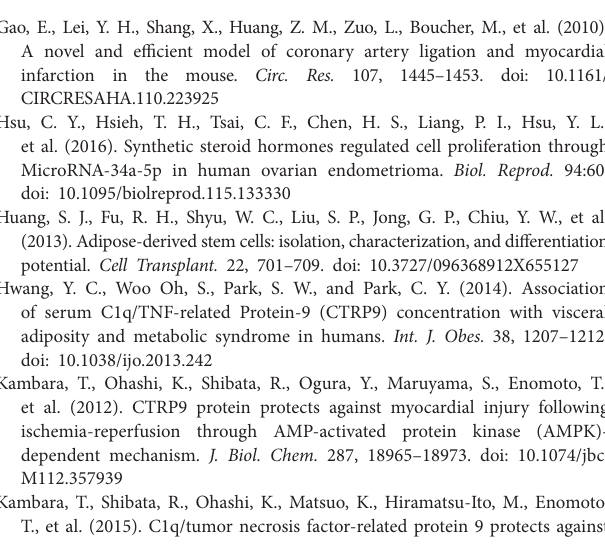
SUPPLEMENTARY FIGURE S1 | Characterization of ADSCs. (A) The molecular markers of ADSCs measured by flow cytometry. Dotted lines indicate IgG isotypic negative controls while solid lines indicate CD105-, CD90-, CD45- and CD31-positive animals. (B) ADSC morphology observed under an optical microscope (200 ×). (C) EGFP fluorescence of ADSCs analyzed under a fluorescence microscope (200 ×). (D) Oil red O staining of adipogenic differentiation ability of ADSCs (400 ×). (E) Alizarin red staining of osteogenic differentiation ability of ADSCs (200 ×). ADSCs, Adipose-derived stem cells; IgG, Immunoglobulin G; EGFP, Enhanced green fluorescent protein.